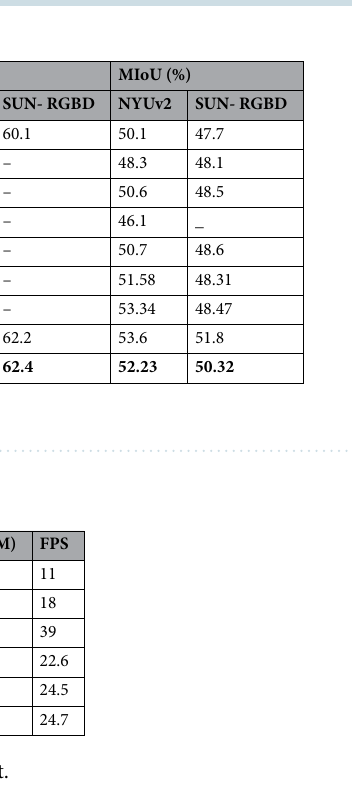
Table 6. Inference Speed test on NYUv2